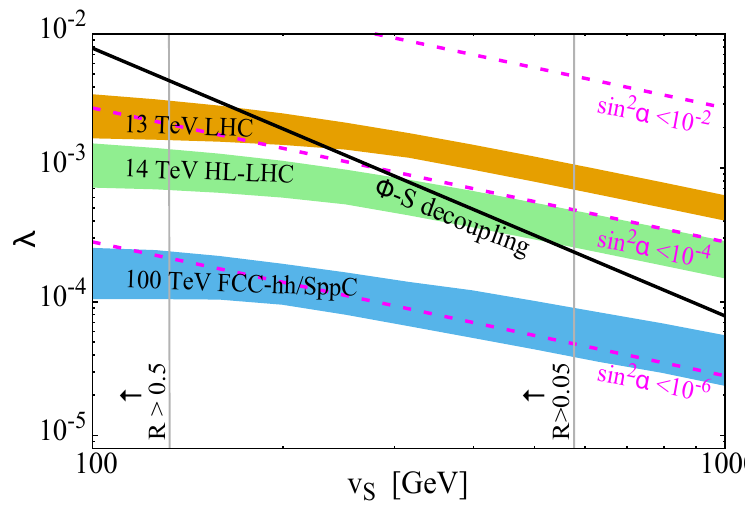
Figure 4 . Projected 95% C.L. sensitivity on v S and (cid:21) for a benchmark m h The yellow, green and blue bands denote limits at the current 13-TeV LHC, 14-TeV HL-LHC and 100-TeV FCC-hh/SppC with 280 fb (cid:0) 1 , 3 ab (cid:0) 1 , 20 ab (cid:0) 1 luminosity, respectively. The black solid S decoupling’ line represents decoupled (cid:8) ; S sectors, satisfying (cid:21)v 2 ‘ (cid:8) (cid:0)